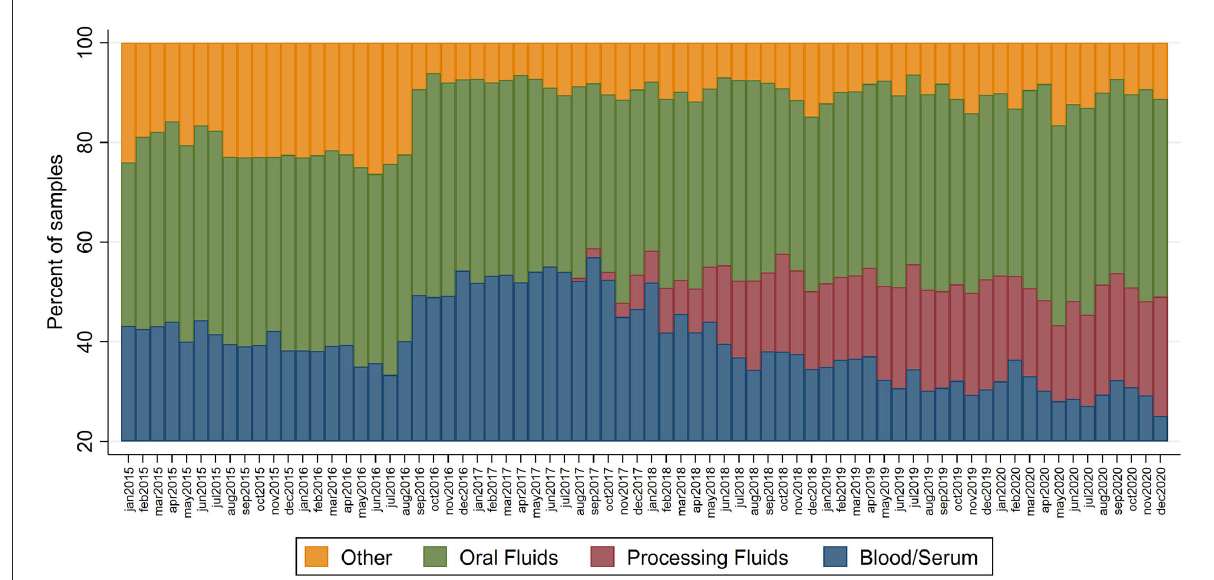
FIGURE2 Percentage of sample type specimens submitted for PRRS RT-PCR diagnosis at the UMN and ISU Veterinary Diagnostic laboratories amongst MSHMP